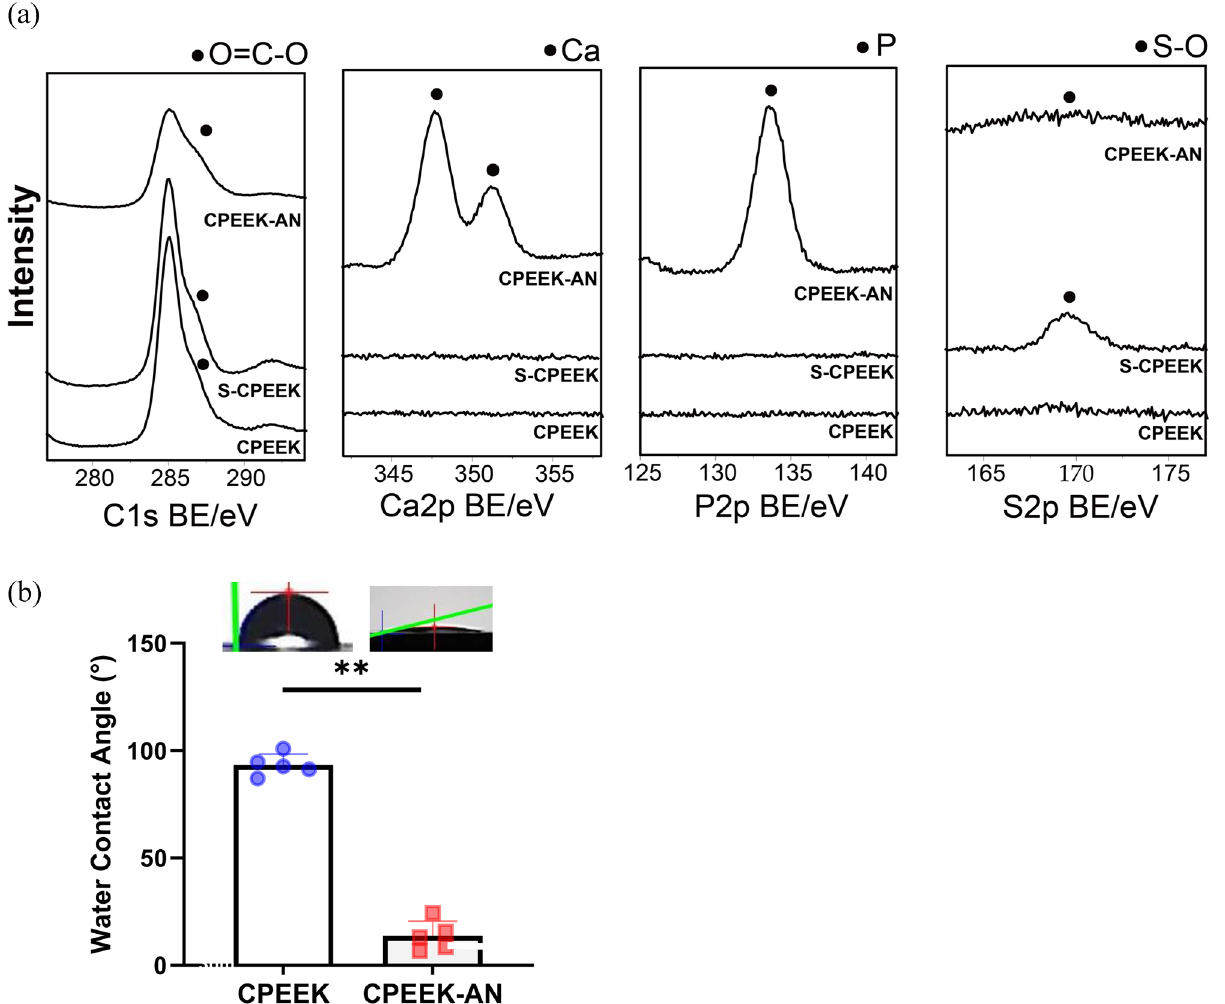
Figure 4. Surface characteristics. ( a ) XPS narrow spectra around the binding energy of C1s, Ca2p, P2p, and S2p on the surface of CPEEK, sulfonated PEEK (S-CPEEK), and CPEEK-AN. ( b ) Water contact angle measured with a contact angle meter. The symbol ‘**” indicates p <